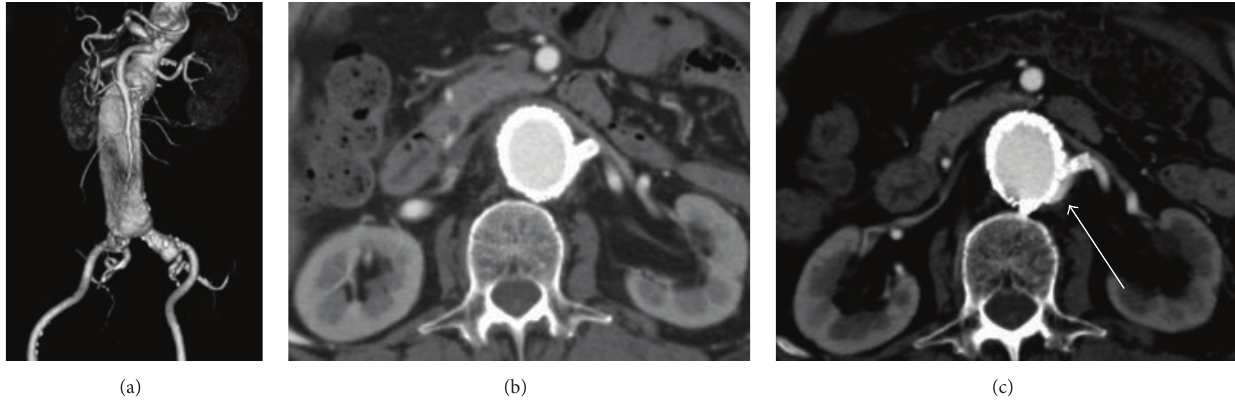
Figure 1: (a) Preoperative 3-dimensional computed tomography with the left anterior oblique view showed a juxtarenal aneurysm measuring 59 mm in diameter with a short proximal neck. (b) Early postoperative computed tomography showed a patent endograft and bare stent to the left renal artery without any endoleaks. (c) Two years after endovascular aneurysm repair, computed tomography showed the enlargement of the aneurysmal sac with a type Ia endoleak (white arrow).